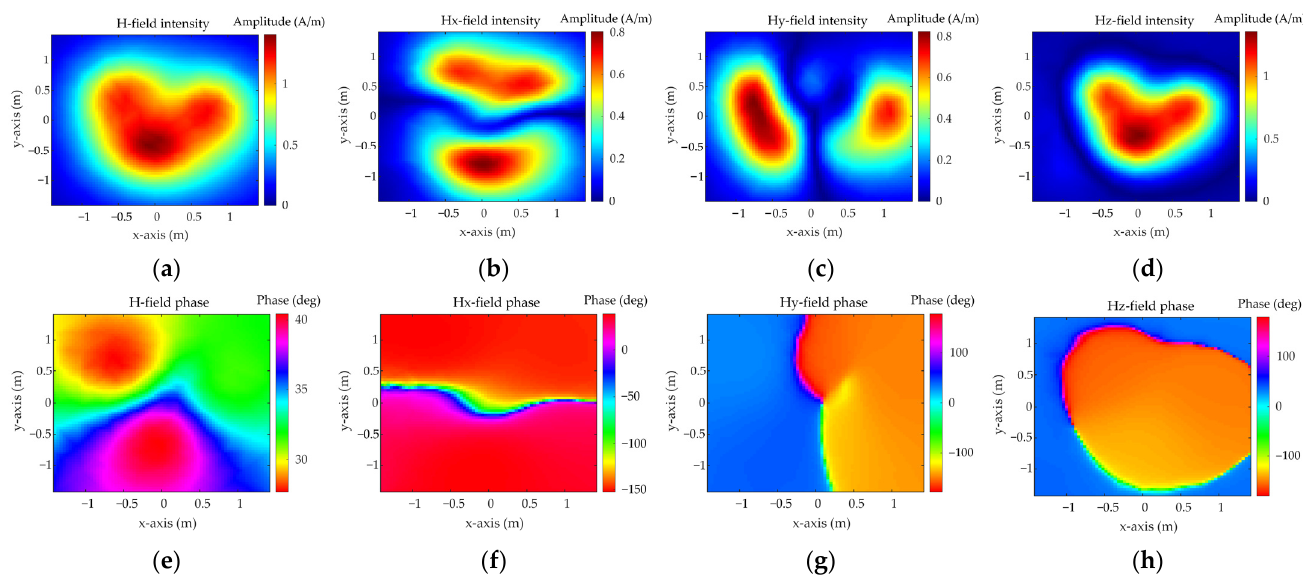
Figure 11. The distribution of the magnetic field which is calculated by the simulation model. ( a ) The amplitude distribution of H; ( b ) The amplitude distribution of Hx; ( c ) The amplitude distribution of Hy; ( d ) The amplitude distribution of Hz; ( e ) The phase distribution of H; ( f ) The phase distribution of Hx; ( g ) The phase distribution of Hy; ( h ) The phase distribution of Hz.